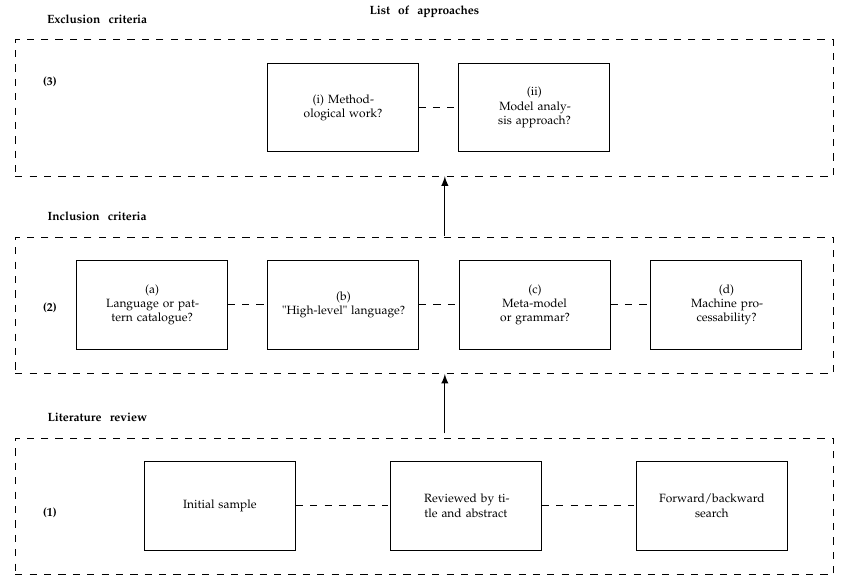
Figure 2. Filtering